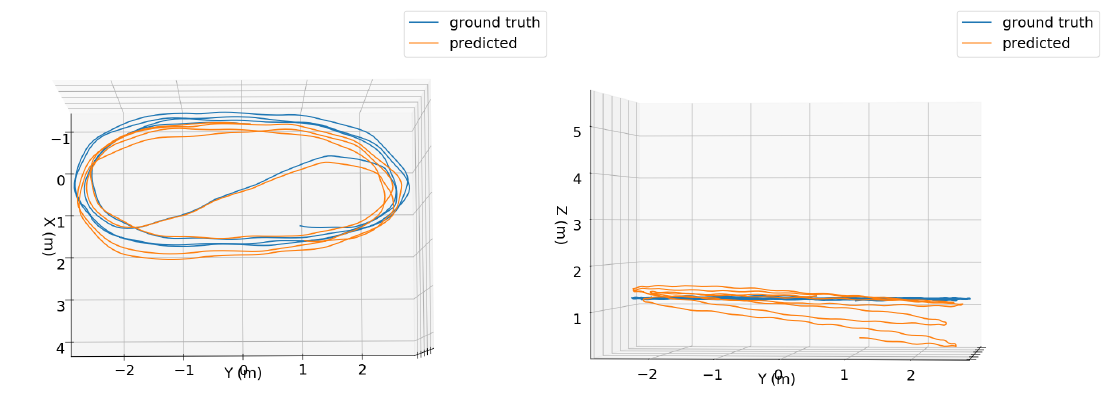
Figure 8. Top ( first column ) and side ( second column ) views of ground truth (blue) and predicted (orange) trajectories for 1 minute of the “handheld/data4/seq1” sequence using the TMAE+QME